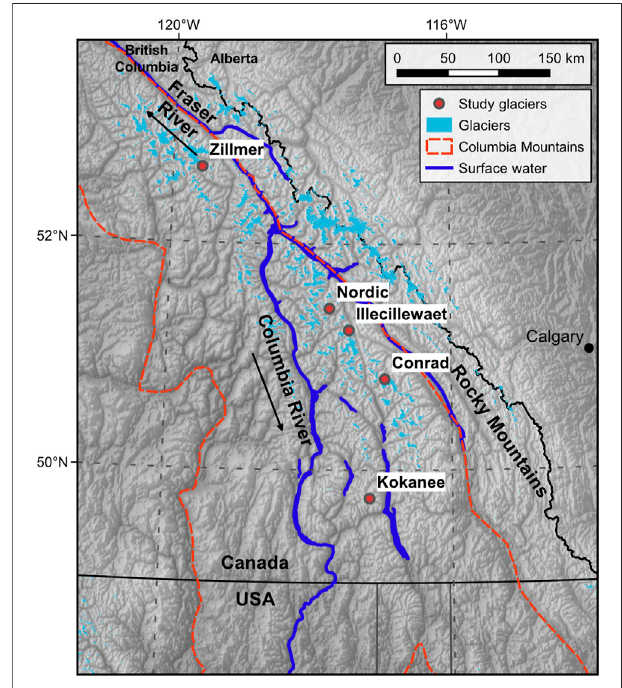
FIGURE 1 | Study glaciers of the Columbia